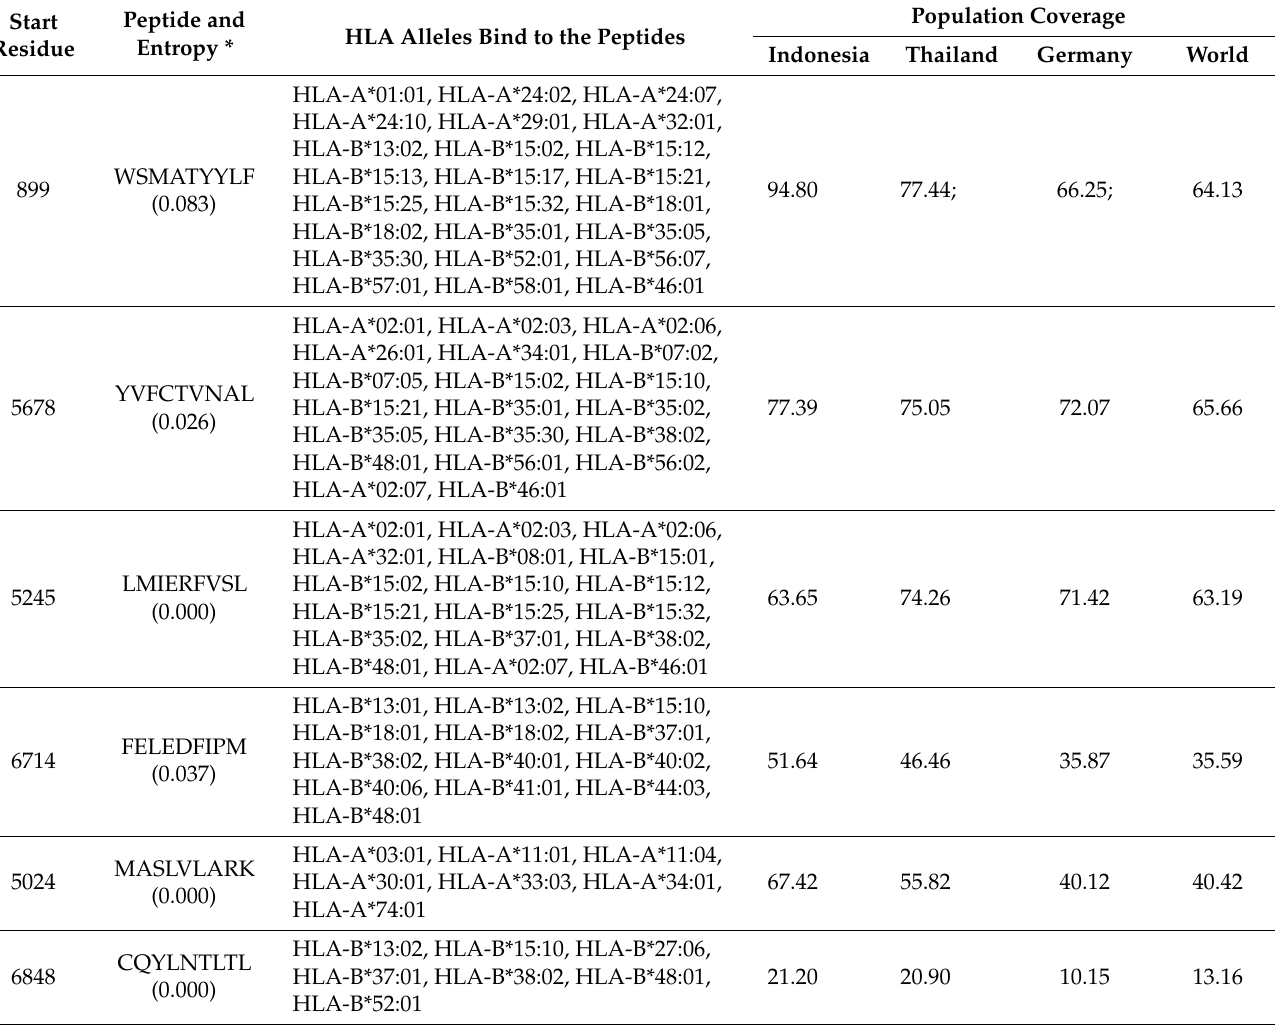
Table 8. Seven CTL and five HTL epitopes chosen for the VC and the population coverage. Epitopes fulfilled the criteria such as highest percentile rank, high promiscuity, high immunogenicity, high IFN γ induction ability, conservancy across all variants, low entropy value, and the absence of homology with human